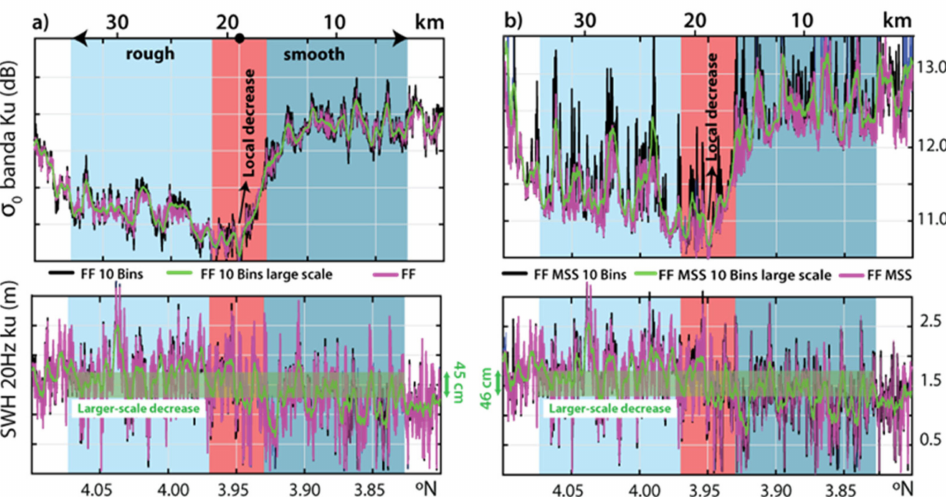
Figure 6. The rectangles depicted in red shades represent the ISW center at 3.95 ◦ N. From the center of ISW, it is considered ± 2 km to each side. To the left of it, we define the “SWH front” ahead of the ISW (“rough” in lighter blue using scales of about 10 km) and to the right, the “SWH rear” (“smooth” in darker blue using 10 km). Top of ( a , b ) shows along-track NRCSs (i.e., σ 0 ) measured by the SRAL altimeter (in synergy with the OLCI) with the SAR-mode retracking color-coded in ( a ) FFSAR, FFSAR 10 Bins and its large-scale mean and in ( b ) FFSAR MSS, FFSAR MSS 10 Bins and its large-scale mean (using a box running average with approximately 3 km). Bottom plots show SWHs’ large-scale variations of 0.45 m in ( a ) and 0.46 m in ( b ), identified in the green shaded rectangles, when comparing the section in front of the primary ISW with that in the